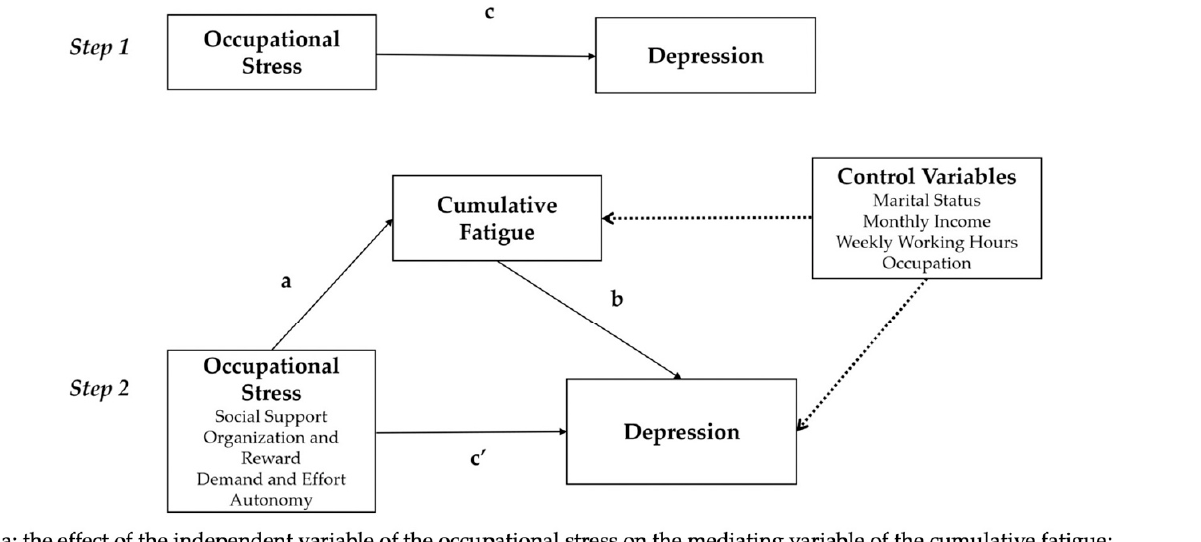
Figure 1. The mediating effect framework of cumulative fatigue between occupational stress and depressive symptoms.